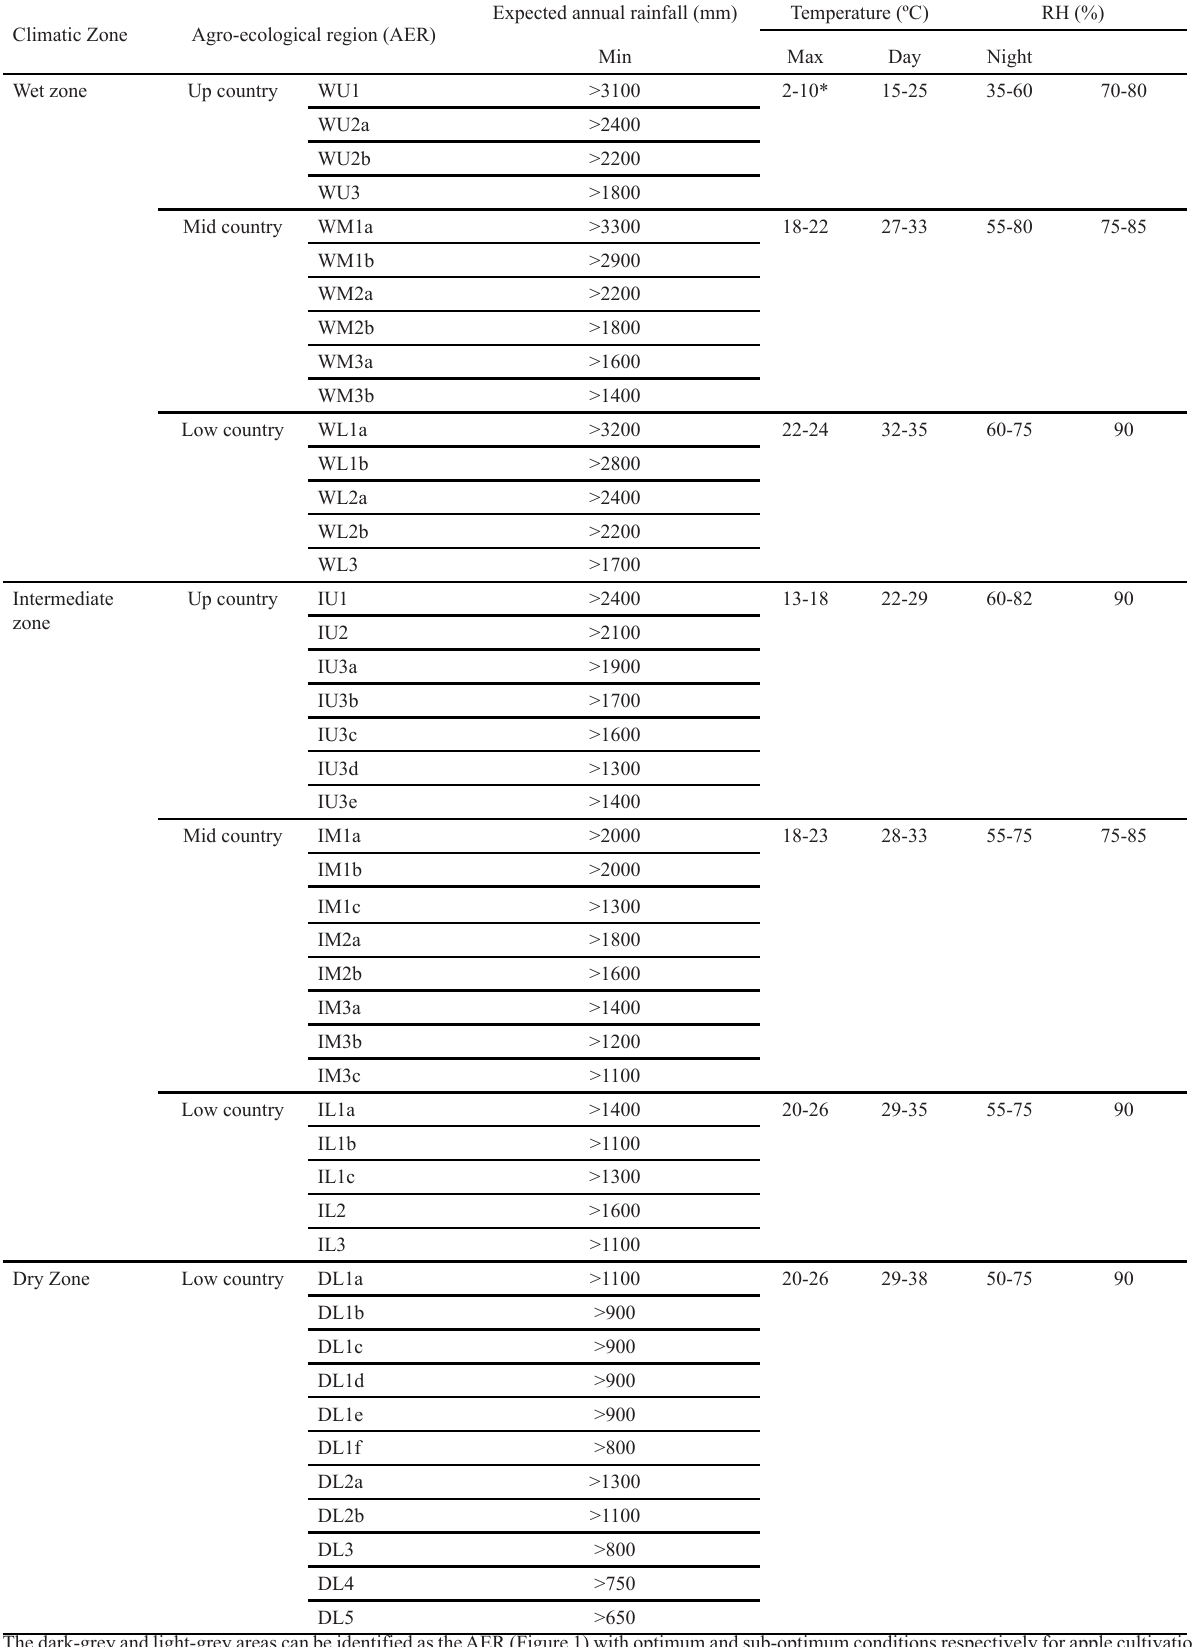
Table 5: Identification of the conducive AER for growing apples in Sri Lanka.